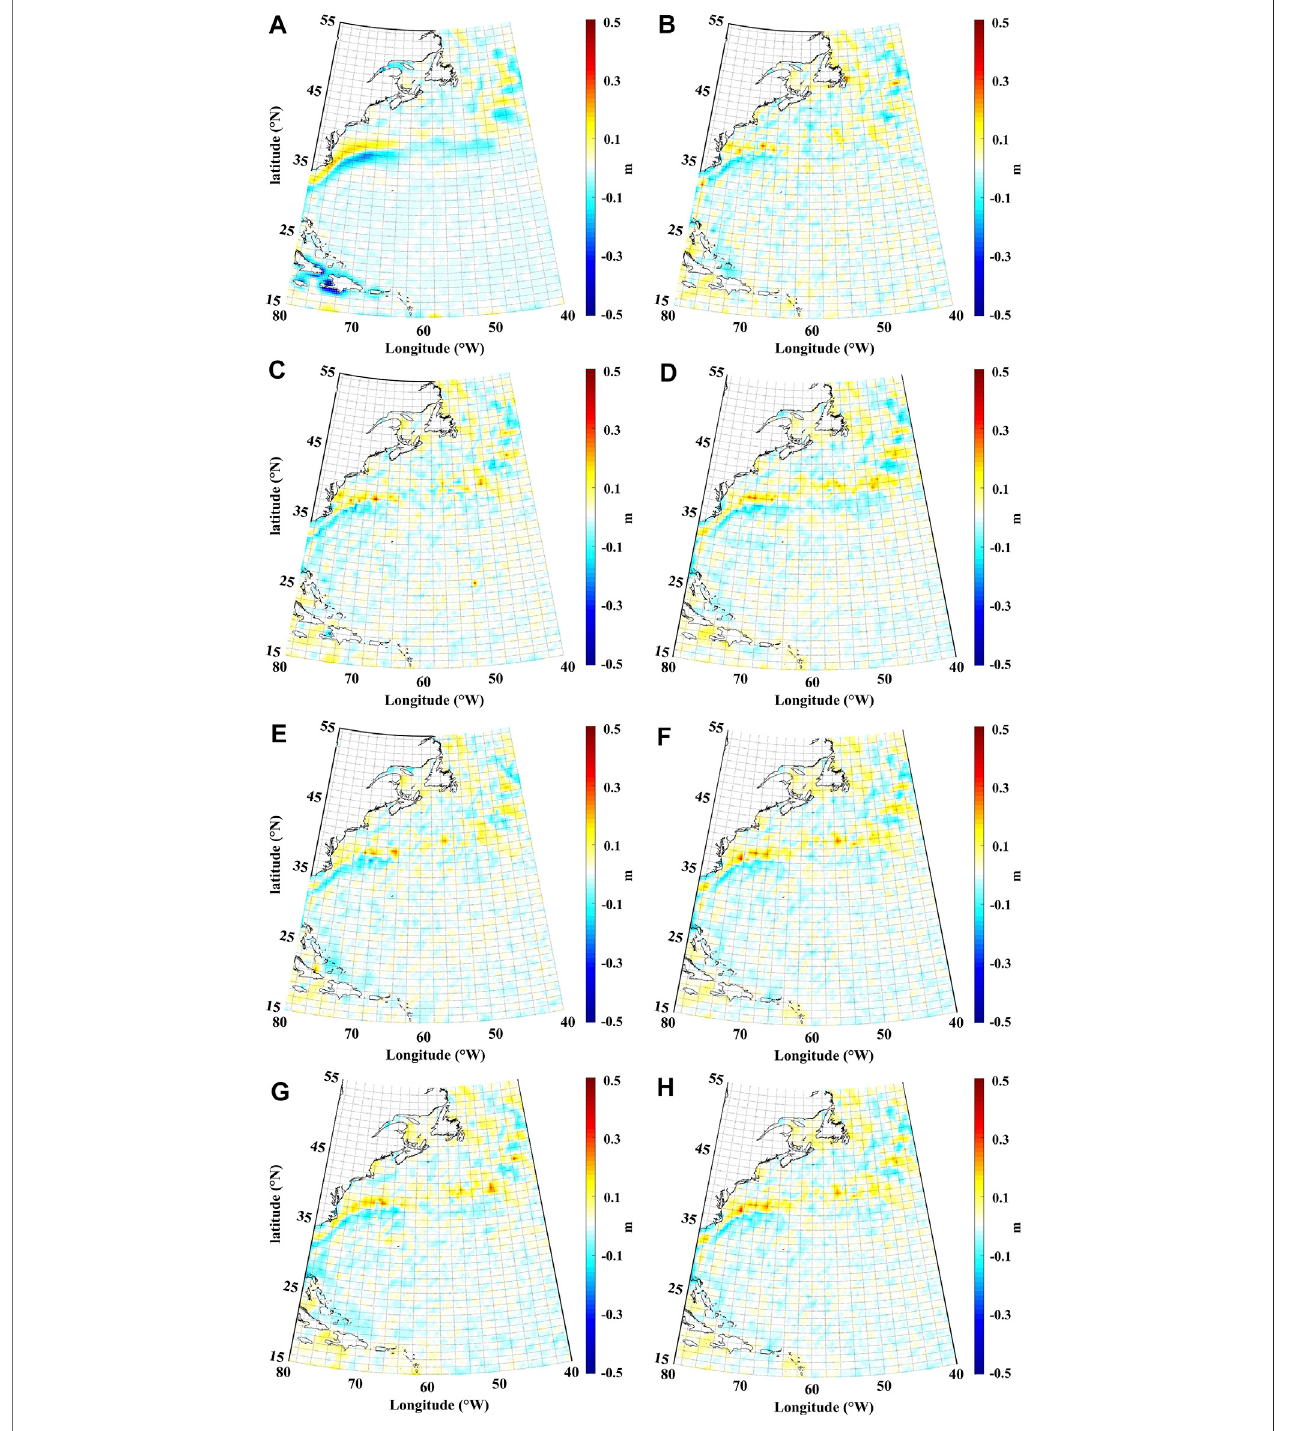
FIGURE 4 | Mis fi ts between estimated MDTs against the Synthetic_MDT. (The MDT solutions using (A) Gaussian fi ltering, (B) DIR4, (C) DIR5, (D) TIM5, (E) DIR6, (F) TIM6, (G) TIM6e, and (H) GOCO06s, against the Synthetic_MDT, respectively. The cs 1 is d/o 260.)